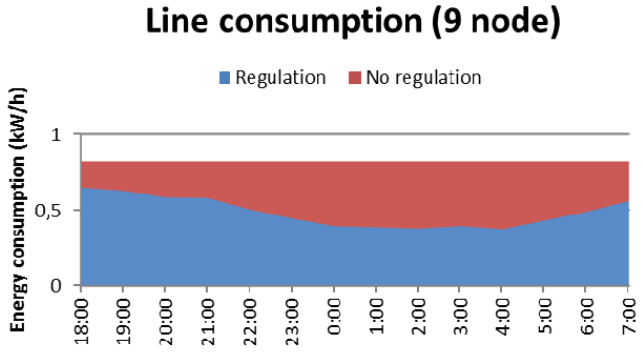
Figure 14. Energy consumption of the line (9